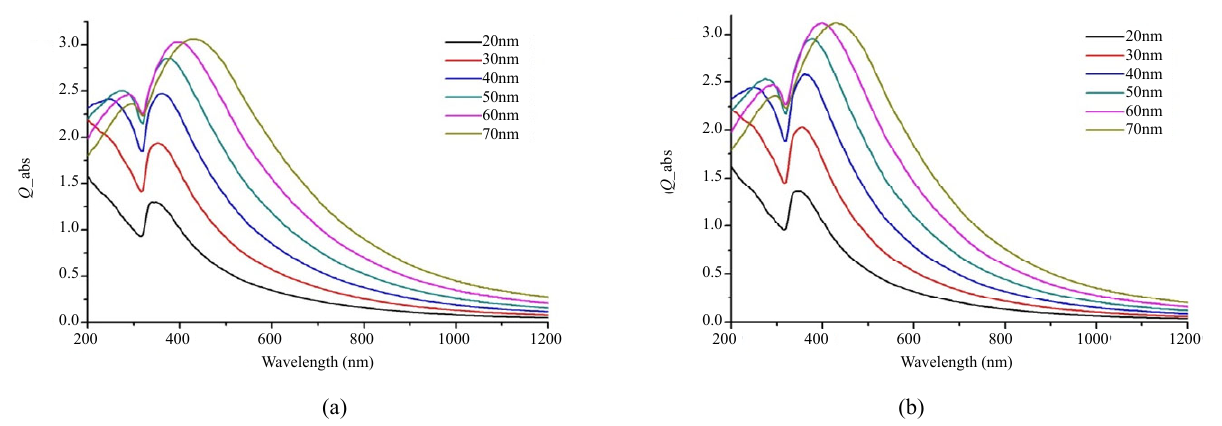
Fig. 5 Absorption spectra of Ag 0.50 -Fe 0.50 alloys nanoparticle for the (a) rounded and (b) sharped corners of the triangular prism.